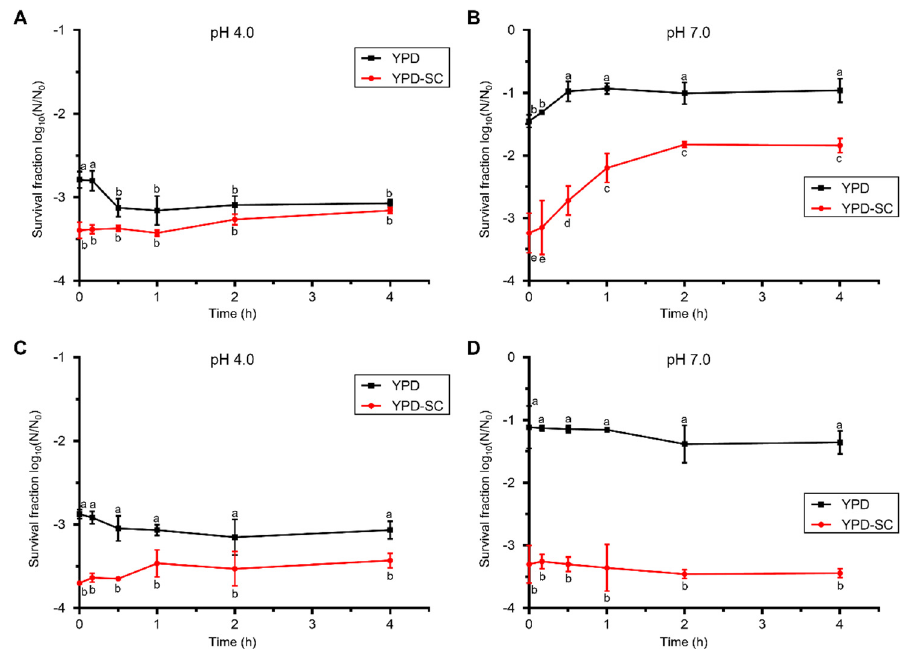
Figure 2. The effect of pH and temperature on the recovery of PEF-injured S. cerevisiae . Survival fraction of S. cerevisiae after the PEF treatment (20 kV/cm for 200 μ s) in citrate-phosphate buffer at pH 4.0 ( A , C ) and pH 7.0 ( B , D ), and in the subsequent recovery process incubated at 30 ° C ( A , B ) or 4 ° C ( C , D ) for 4 h. YPD, non-selective medium; YPD-SC, selective medium. Data are expressed as mean ± standard deviation. Significant differences are indicated by different letters ( p < 0.05).